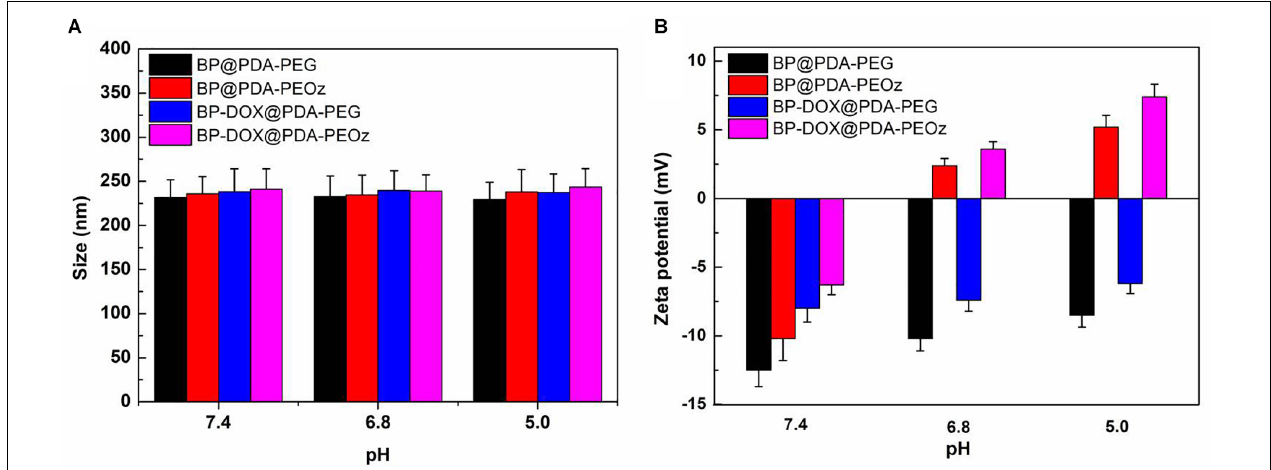
FIGURE 4 | (A) Variations of the size for BP@PDA-PEG, BP@PDA-PEOz, BP-DOX@PDA-PEG, BP-DOX@PDA-PEOz in water solution with different pH of 7.4, 6.8 and 5.0 values at 37 ◦ C ( n = 3). (B) Zeta potential of the BP@PDA-PEG, BP@PDA-PEOz, BP-DOX@PDA-PEG, BP-DOX@PDA-PEOz in different pH of 7.4, 6.8, and 5.0 ( n =